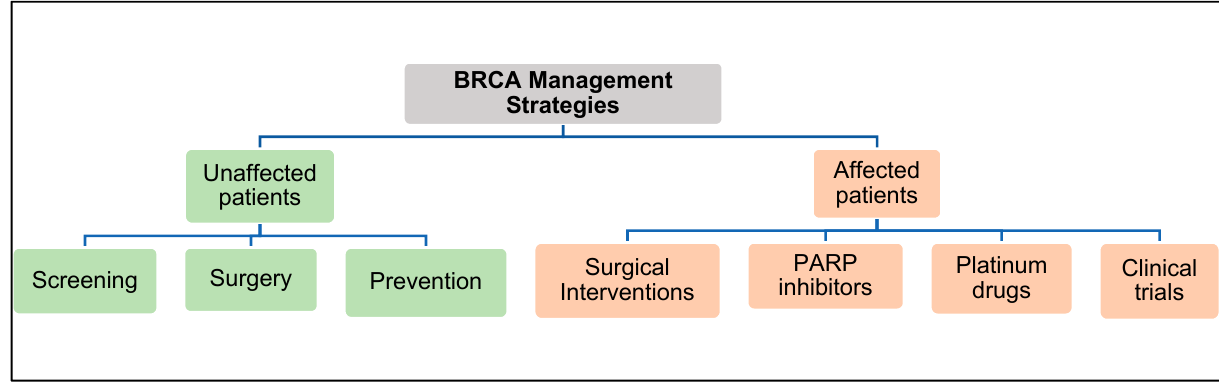
Figure 6. BRCA2 Management Strategies.